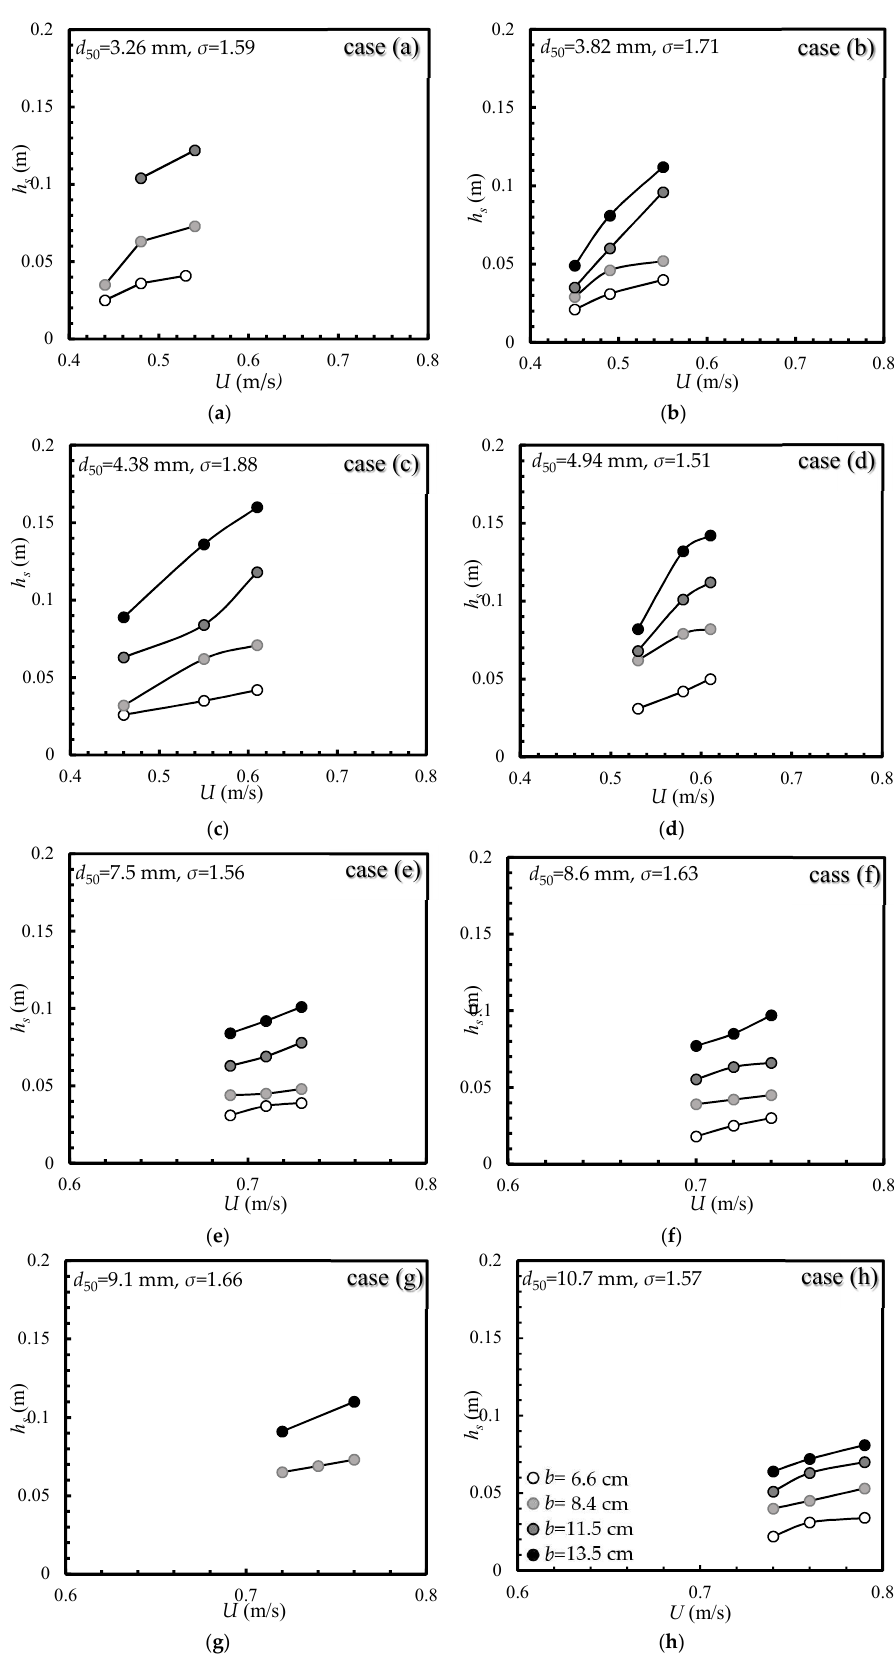
Figure 3. Maximum scour depth variation with approach flow velocity.